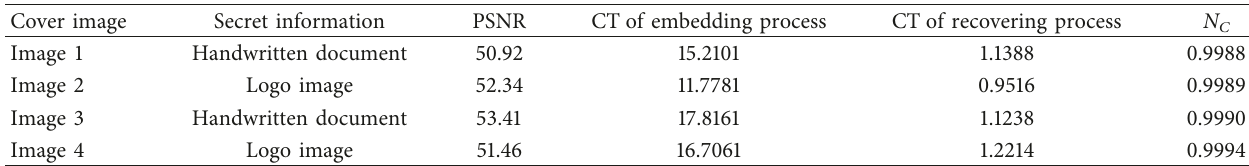
Table 2: Quality measures of the proposed